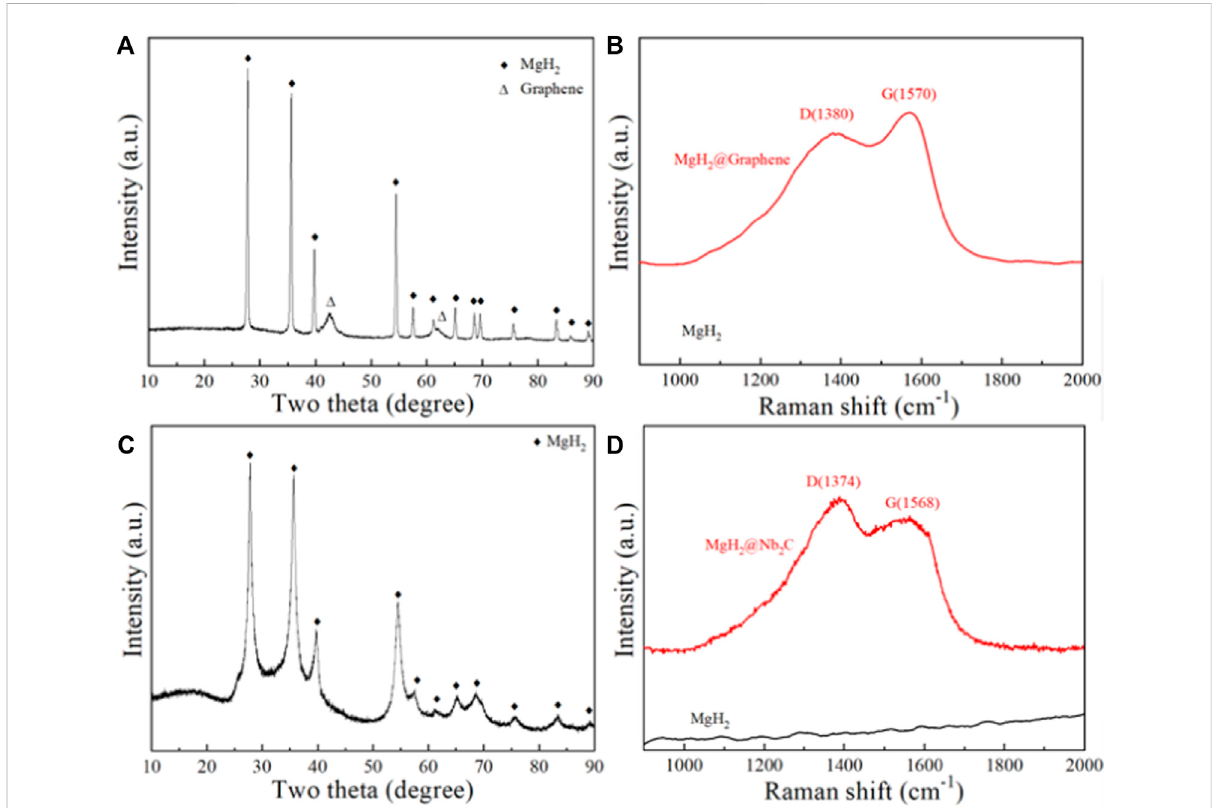
FIGURE 1 MgH 2 @Graphene composites for (A) XRD pattern and (B) Raman pattern, MgH 2 @Nb 2 C composites for (C) XRD pattern and (D) Raman